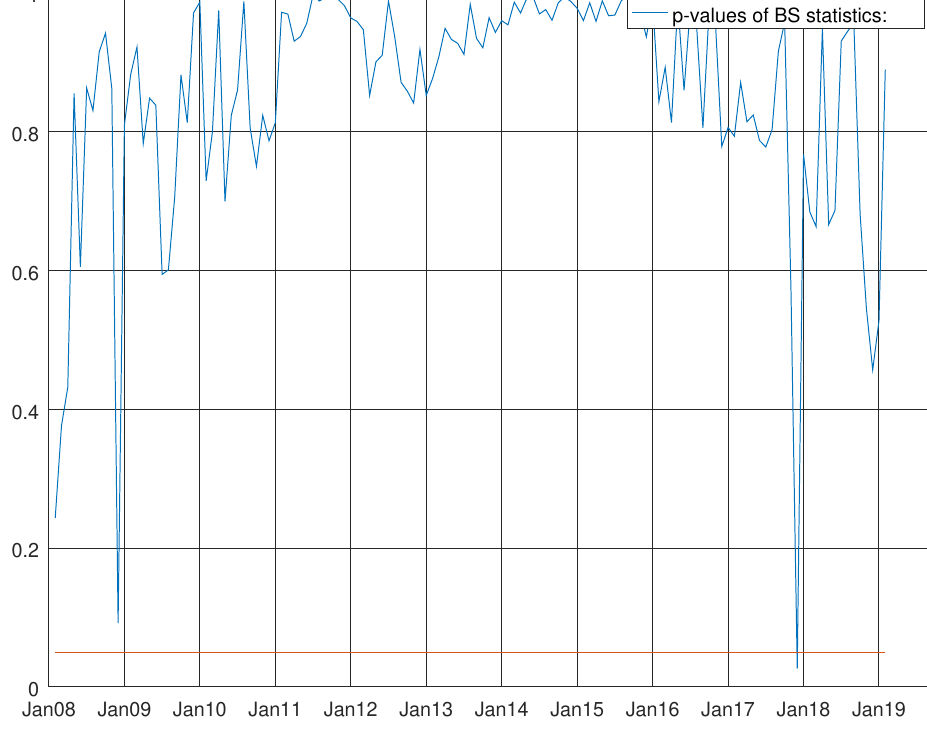
Figure 13. Graph showing the p -values of the Bowman–Shenton test for the enhanced model for intermediate goods. The null hypothesis states that errors are normally